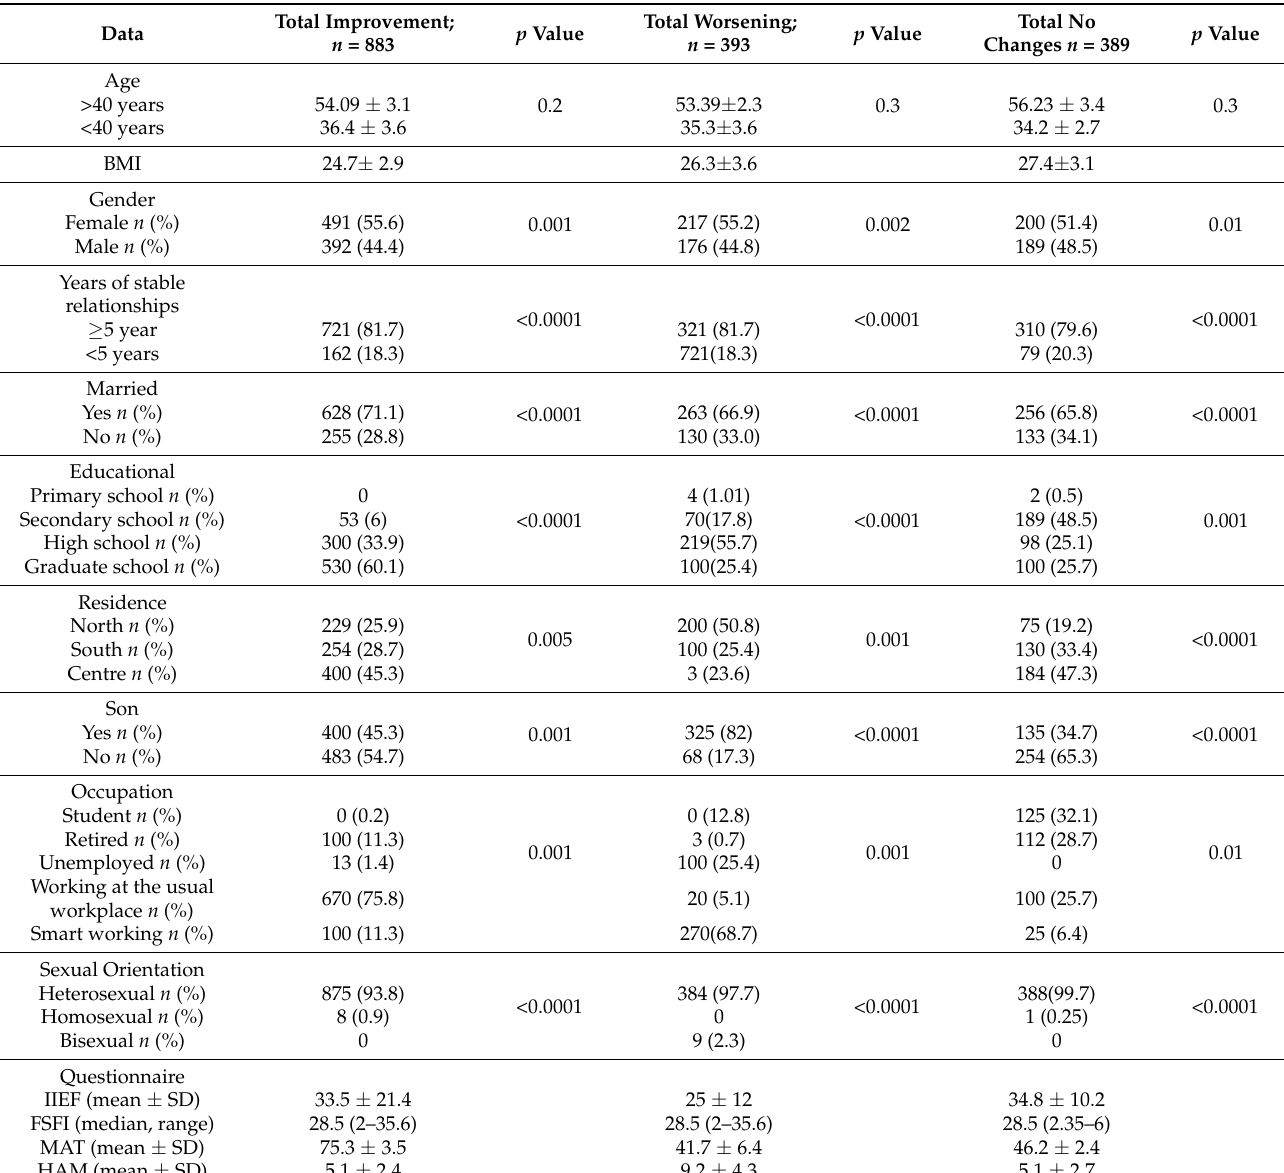
Table 4. Demographic data on subjects who lived with their partners during the lockdown, and reported an improvement, worsening, or no changes in the couple’s sex